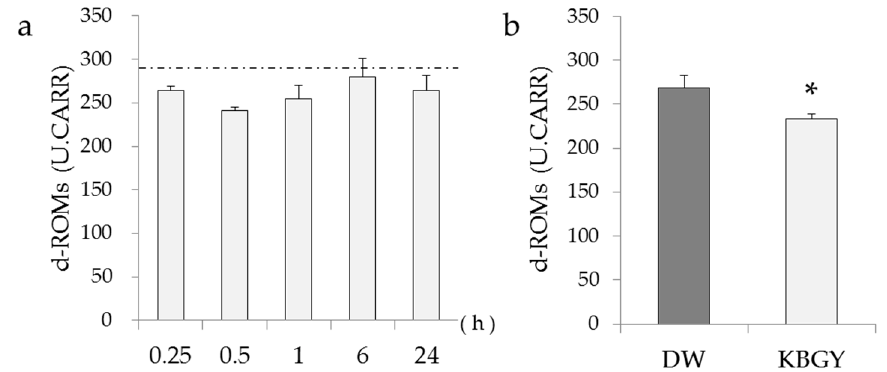
Figure 3. Decreased level of reactive oxygen metabolites by administration of KBGY. Plasma samples were obtained at 0.25, 0.5, 1, 2, 4, 6, 10, and 24 h after single administration of KBGY (2 g/10 mL/kg, p.o.). The levels of diacron-reactive oxygen metabolites (d-ROMs) in plasma were evaluated. ( a ) Time-course was investigated ( n = 3). The levels of d-ROMs of the plasma obtained from non-administrated rats were represented as dashed lines; ( b ) Plasma samples were obtained 0.5 h after the administration of KBGY or distilled water (DW). Data are shown as the mean ± S.E. of 10 rats. * p < 0.05 indicates significant versus DW group from the unpaired Student’s t -test.